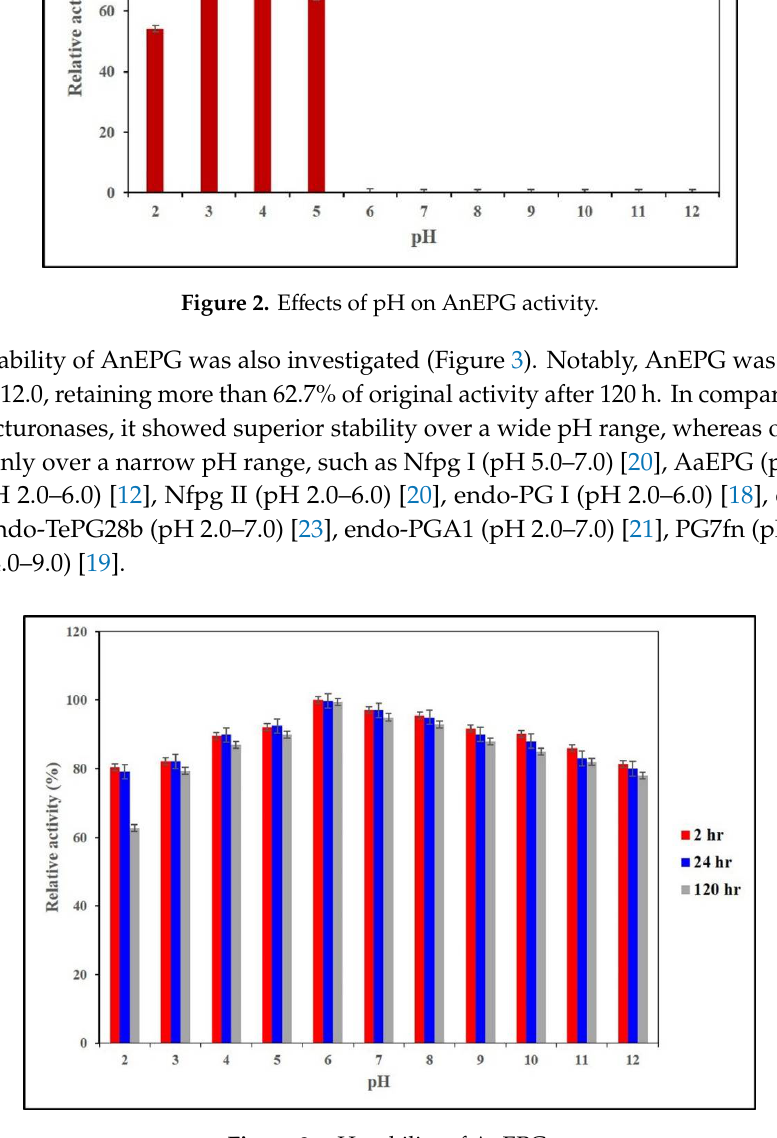
Figure 3. pH stability of AnEPG.